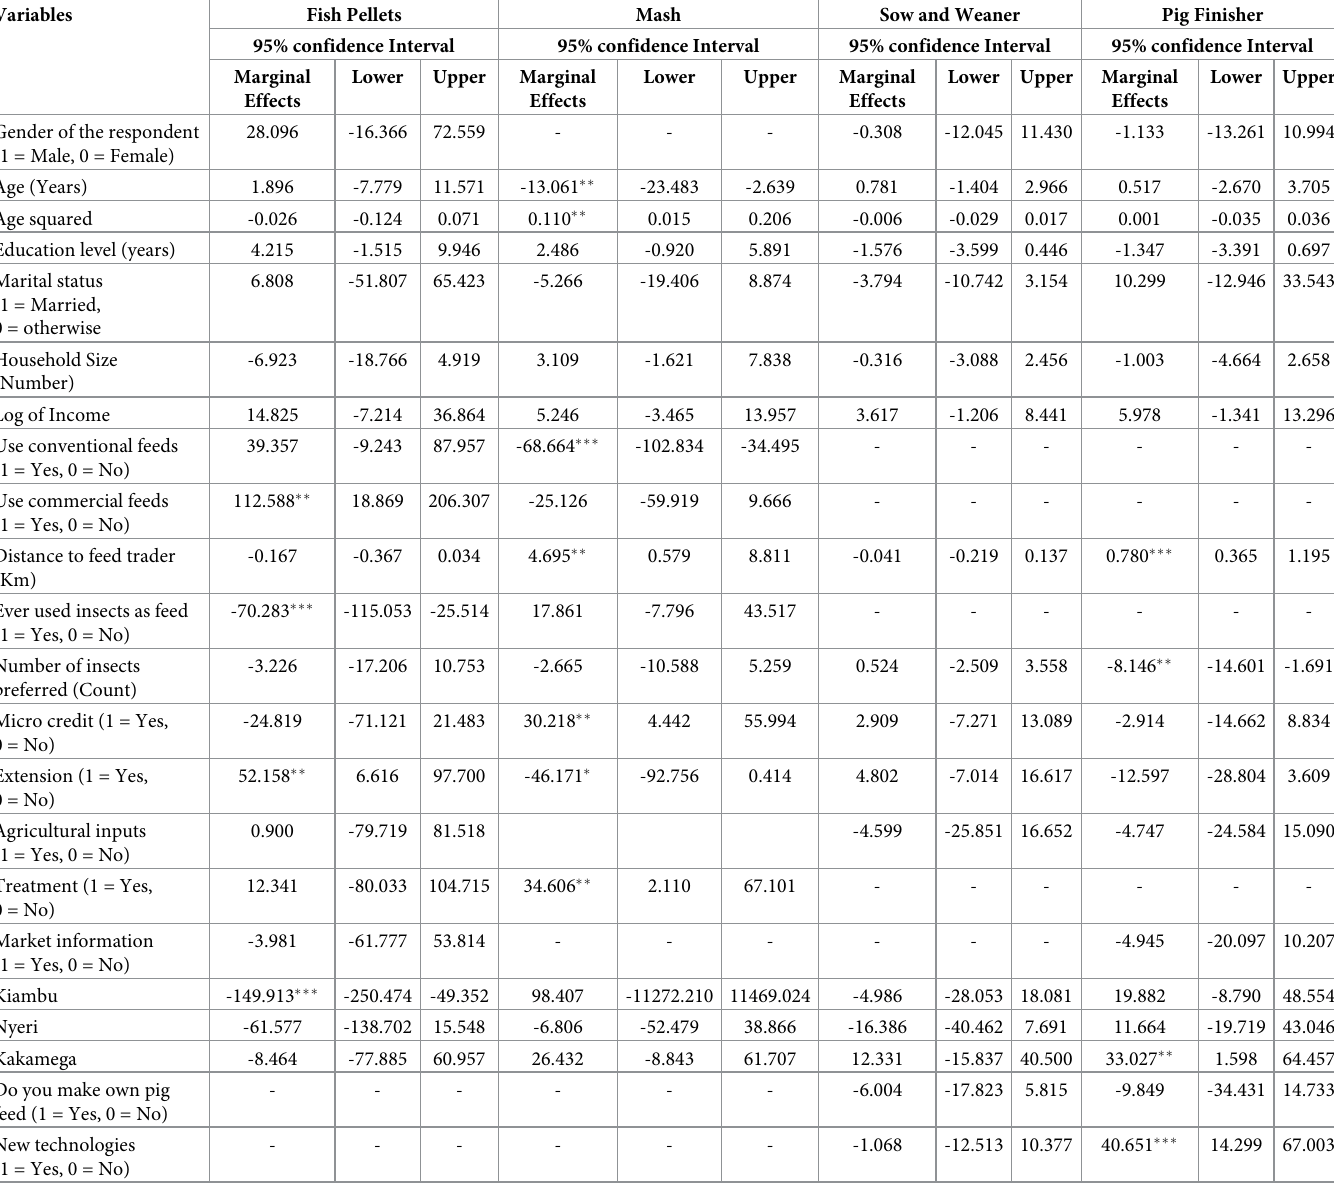
Table 5. Regression results for factors influencing willingness to pay (WTP) for insect-based feeds among fish and pig